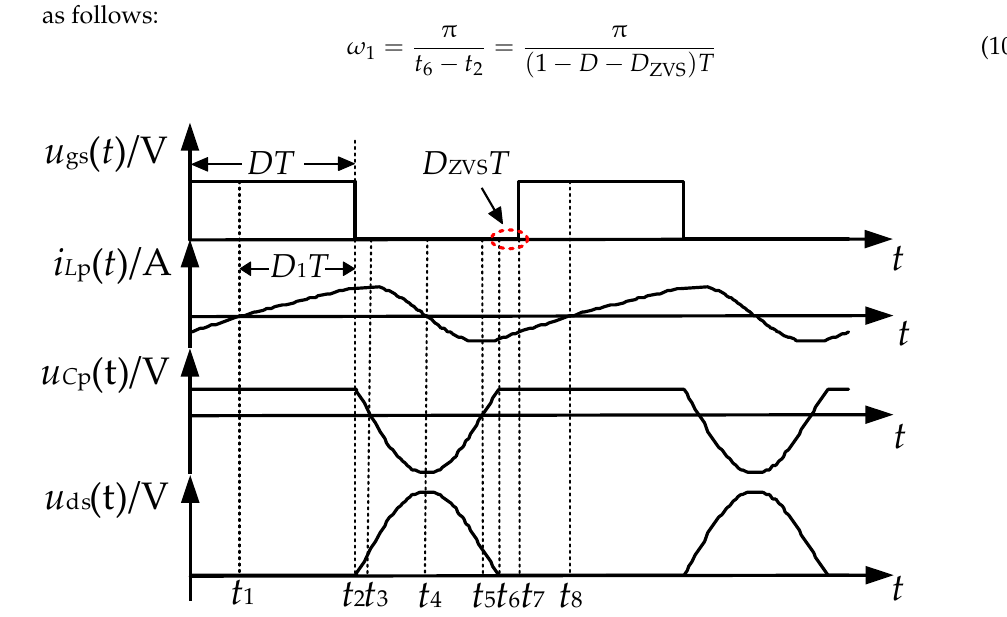
Figure 7. Relevant voltage and current operating waveforms.